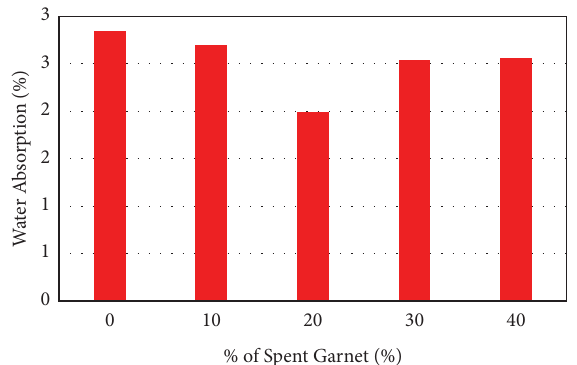
Figure 18: Water absorption of POC LWAC containing spent garnet.